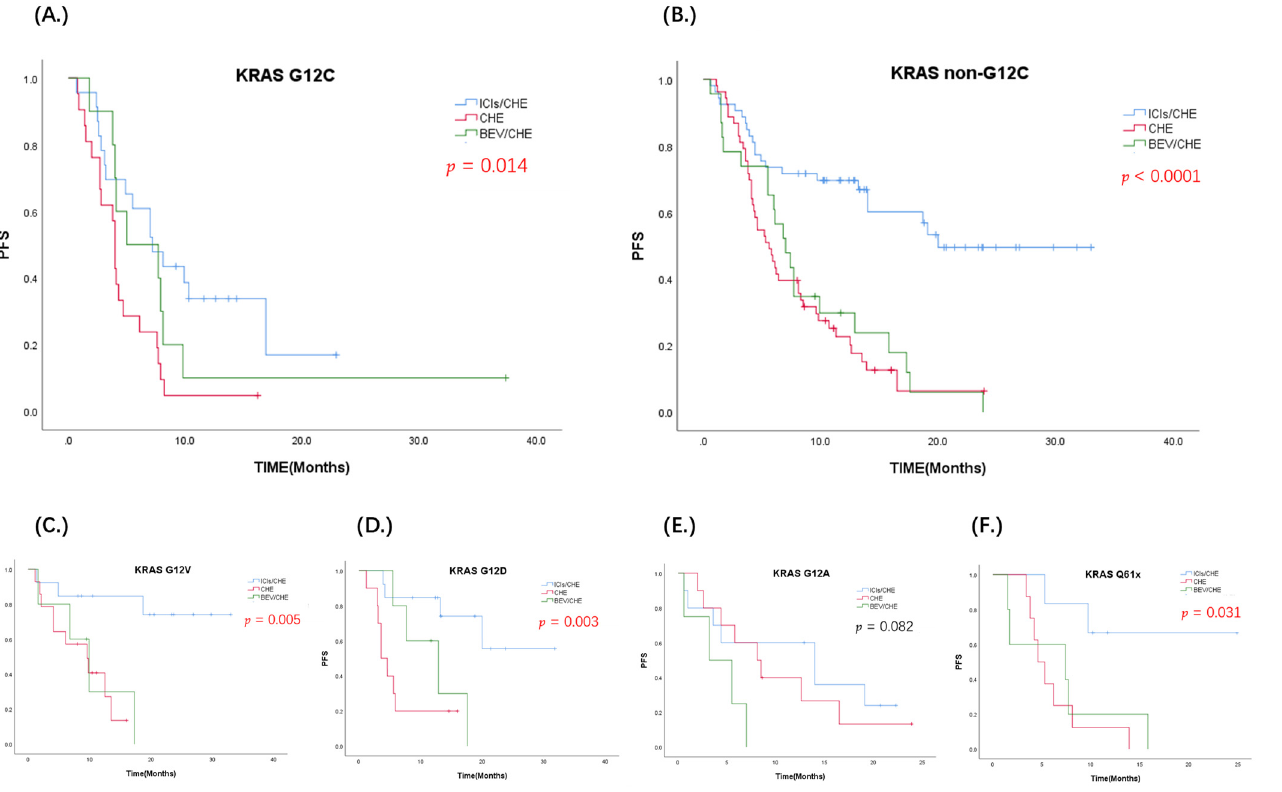
Figure 4. Kaplan–Meier PFS curve of three treatment groups in each KRAS subtype; The blue curve represents ICIs/CHE group, the red curve represents CHE group, and the green line represents CHE/BEV group ( p < 0.05, statistical significance; p < 0.001, significant statistical significance, red indicates. p ≥ 0.05, no statistical significance, black indicates); ( A ) KRAS G12C; ( B ) KRAS non-G12C; ( C ) KRAS G12V; ( D ) KRAS G12D; ( E ) KRAS G12A; ( F ) KRAS Q61x.